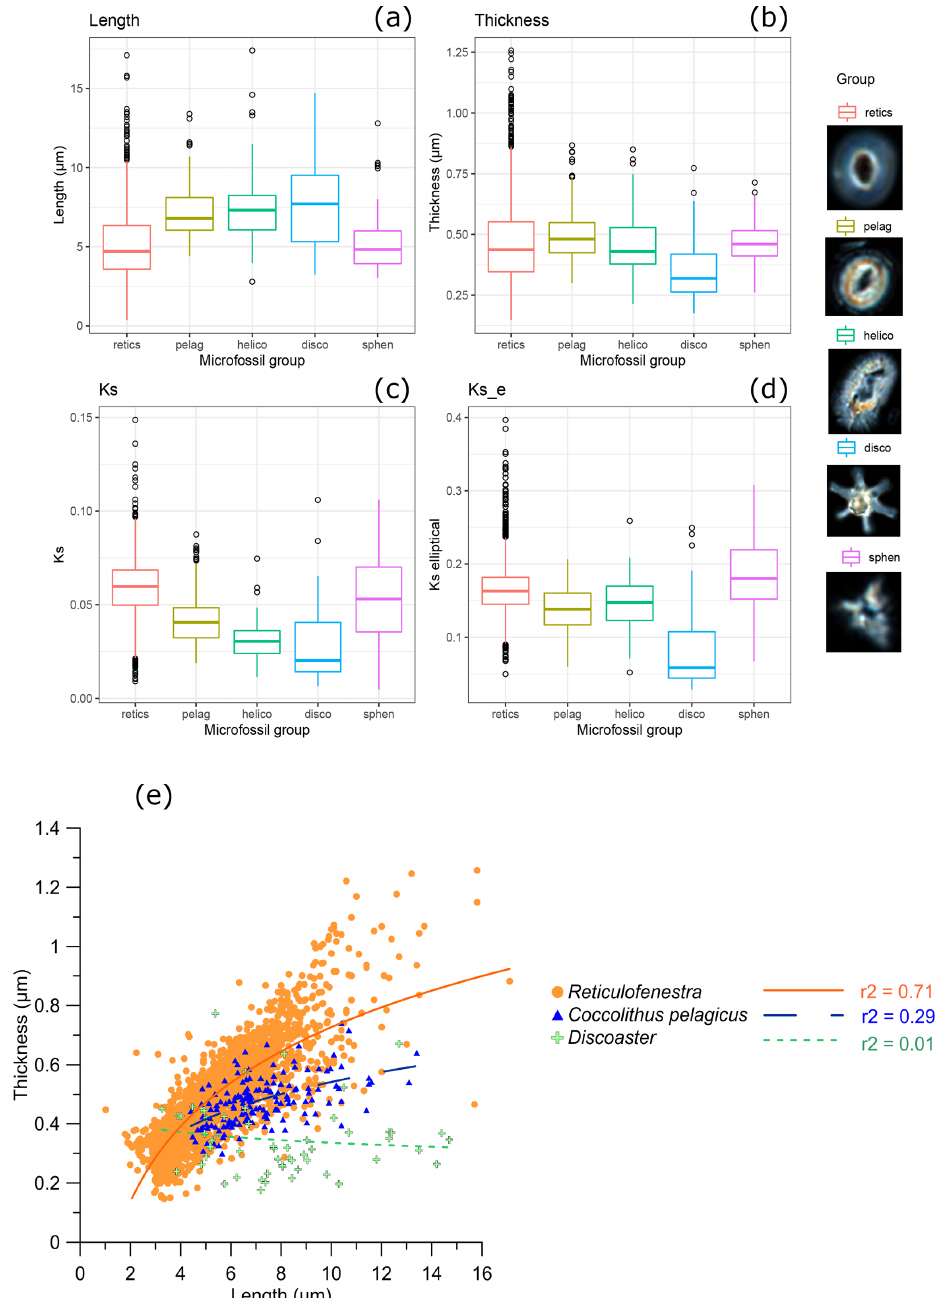
Figure 4. Box-and-whisker plot showing (a) length, (b) thickness, (c) k s , and (d) k se for taxa in all samples and thumbnail examples of Reticulofenestra (retics), Coccolithus pelagicus (pelag), Helicosphaera (helico), Discoaster (disco), and Sphenolithus (sphen). (e) Plot of thickness vs. length for all Reticulofenestra , Coccolithus , and Discoaster